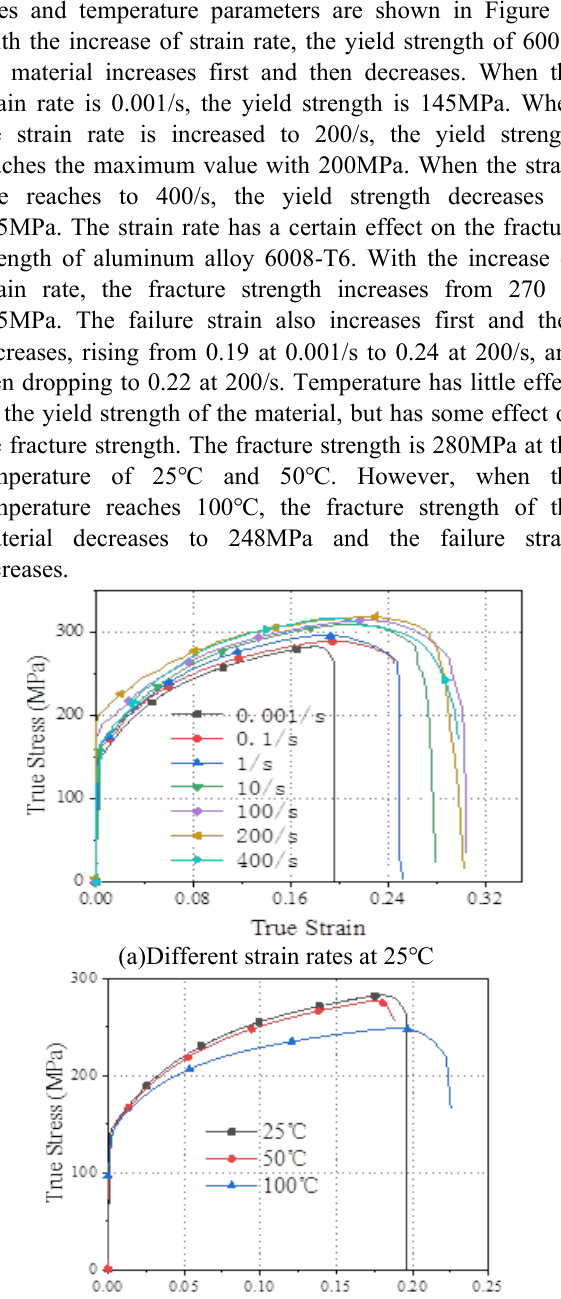
Figure 3. True stress-strain curve for 6005A-T6.